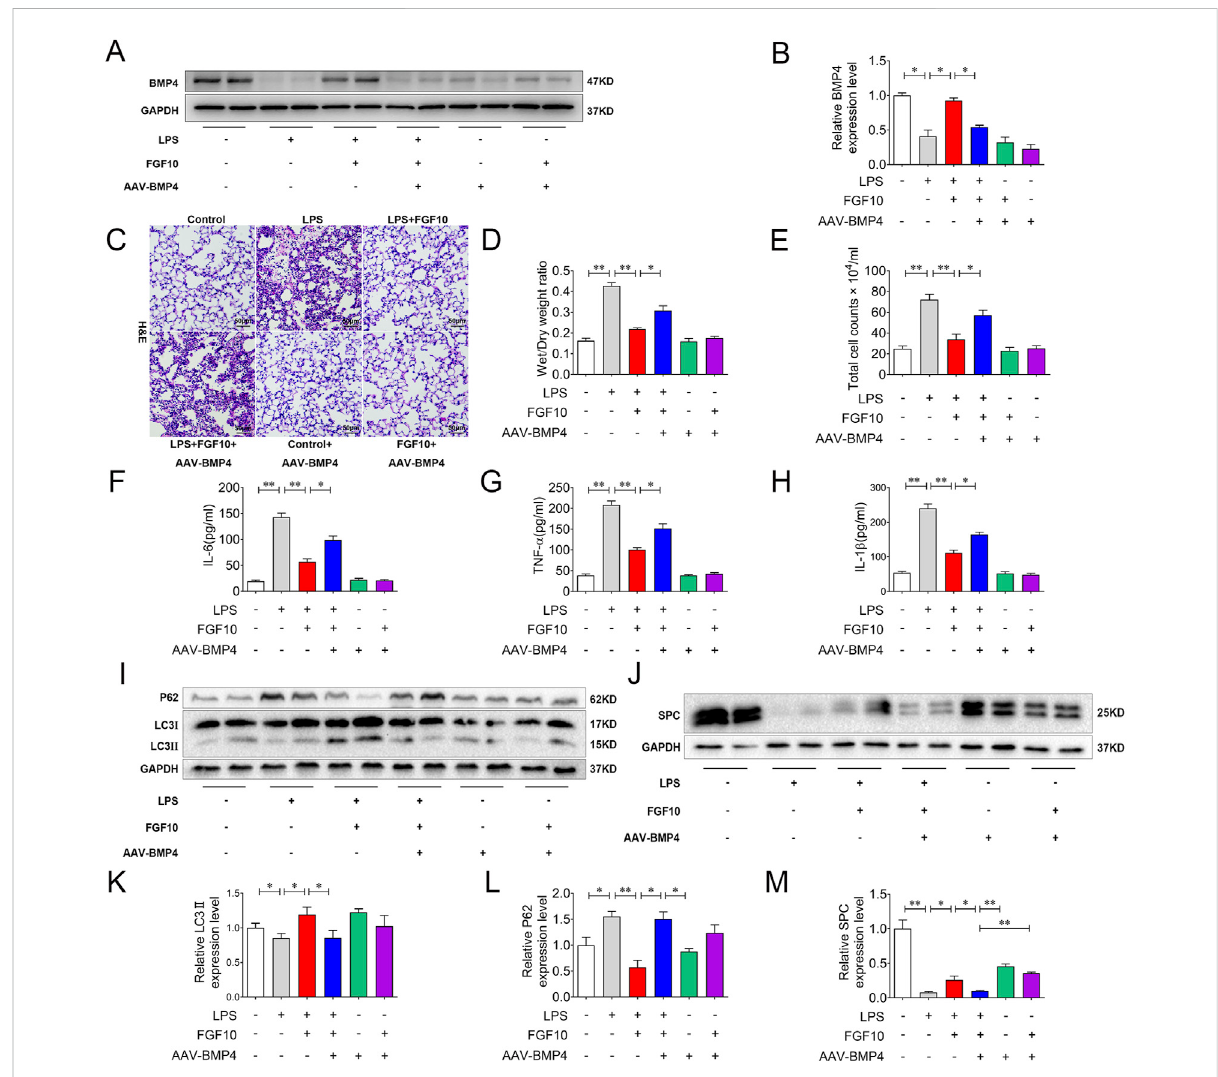
FIGURE 5 BMP4knockdownweakenstheprotectiveeffectofFGF10onacutelunginjurybyautophagy. (A) TheexpressionofBMP4inmicewasdetected by Western blotting. (B) Quantitative analysis of BMP4 protein. (C) Pathological change in lung tissue was detected by H&E (200×). (D) Quantitative analysis of wet/dry weight ratio. (E) BAL fl uid was obtained to differentially count total cells. (F – H) The expression of IL-6, TNF- α , and IL-1 β in BALF fl uid was analyzed by ELISA. (I,J) The expression of LC3, P62, and SPC in mice was detected by Western blotting. (K – M) Quantitative analysis of LC3, P62, and SPC protein. The data were presented as the mean ± SEM, n = 5. * p < 0.05, * * p <